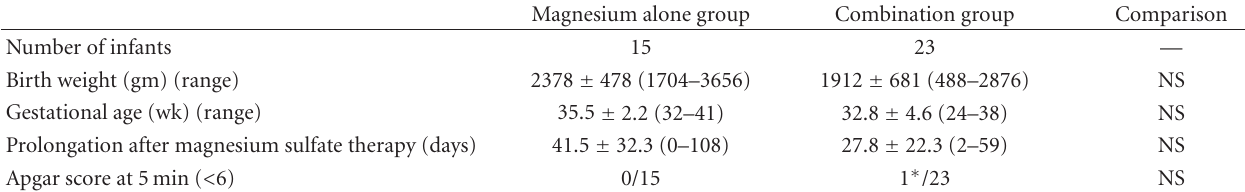
Table 4: Neonatal outcomes of magnesium alone and combination